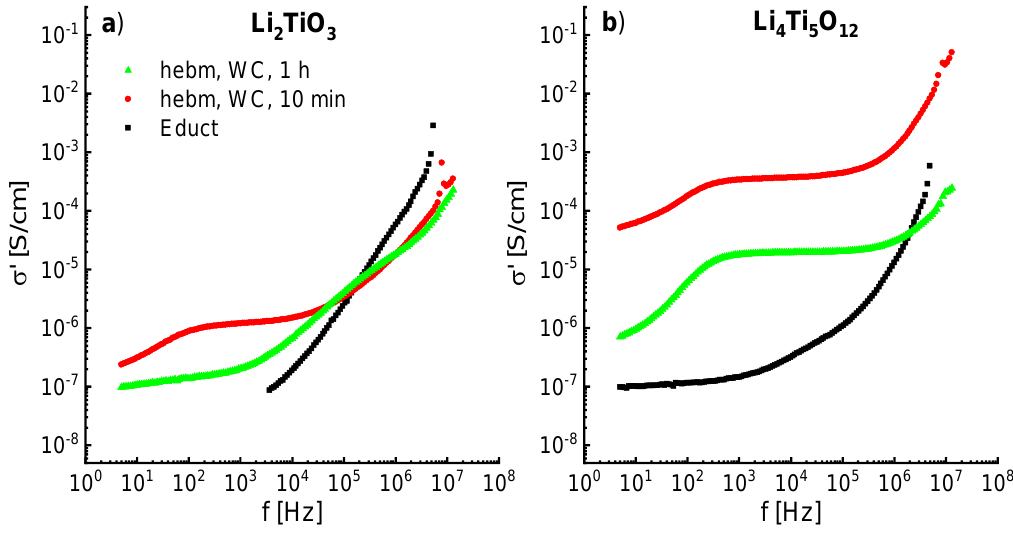
Figure 12. Frequency dependent real part of the conductivity at 298K of ( a ) Li 2 TiO 3 and ( b ) Li 4 Ti 5 O 12 before and after milling at ( a ) 600 rpm and ( b ) 400 rpm for 10 min and 1 h. The conductivity of Li 2 TiO 3 from the solid-state reaction is rather poor and is immeasurable at frequencies below 3 kHz. After milling for 10 min an increase of one order of magnitude can be observed, with a typical dc plateau ( σ dc ≈ 10 − 6 S/cm) at lower frequencies and a dispersive regime